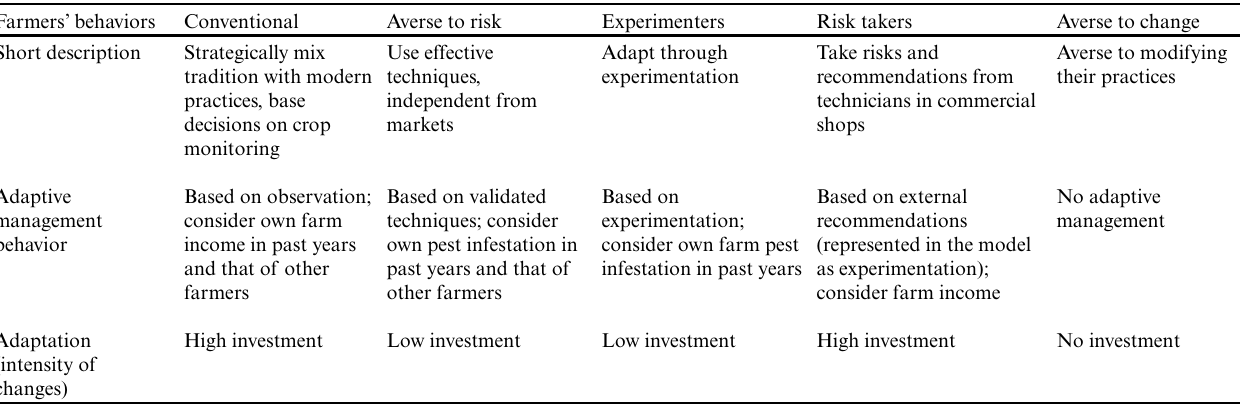
Table 1 . Characteristics of behaviors followed by Ecuadorian farmers.